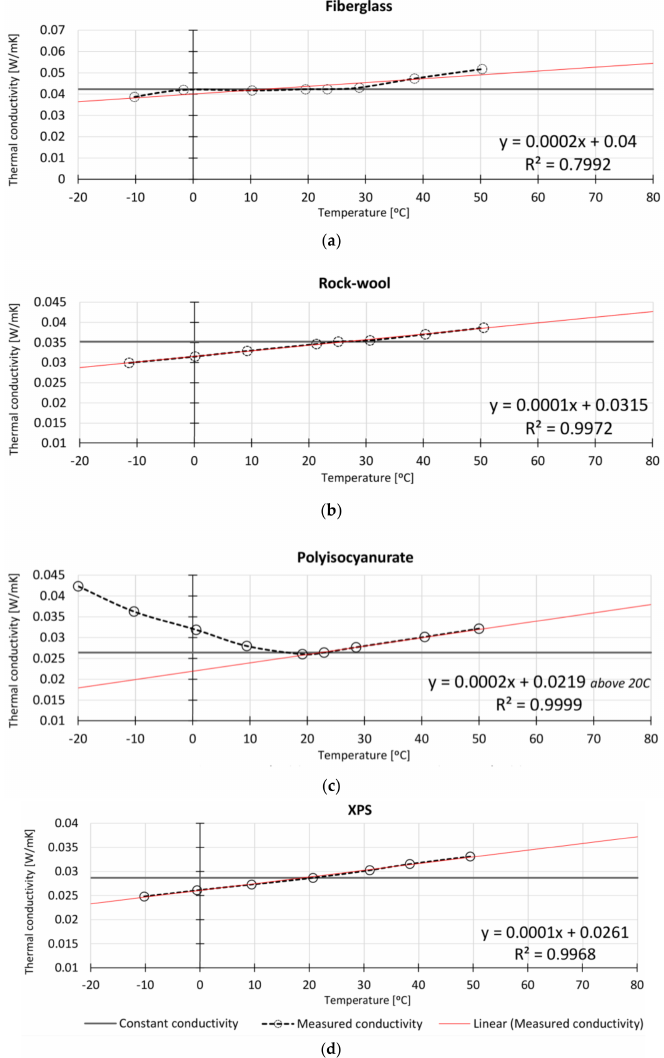
Figure 3. Temperature dependence of the thermal conductivity for the four analyzed materials, comparing constant, linear, and measured values. ( a ) Fiberglass; ( b ) Rockwool; ( c ) Polyisocyanurate; ( d ) Extruded